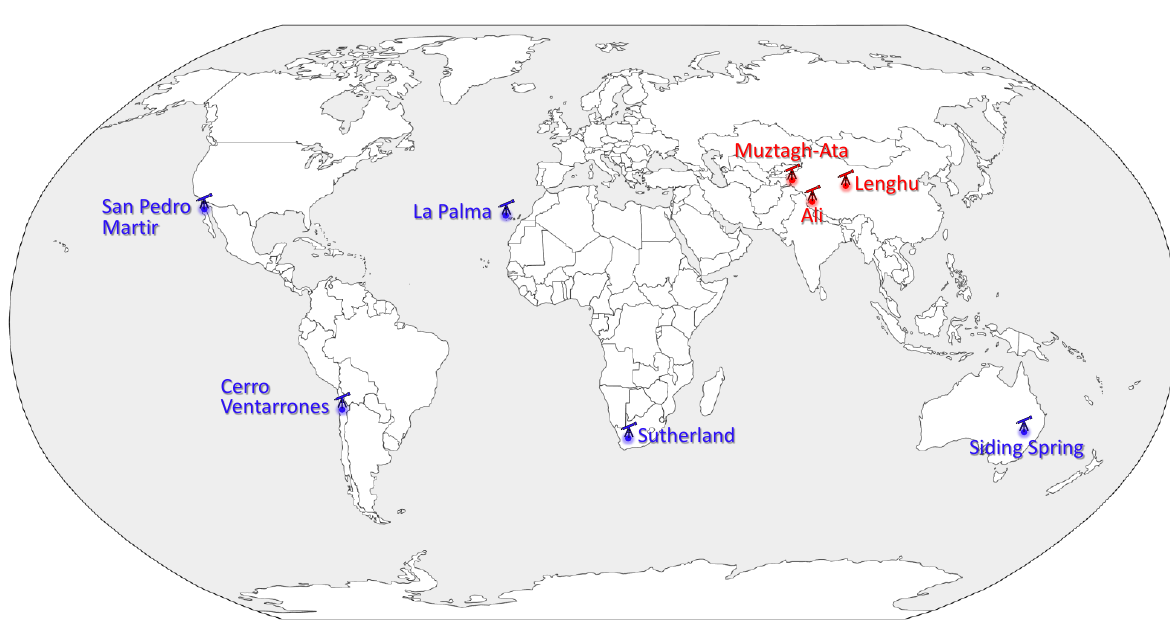
Figure 2. Location of the three Chinese sites (in red) confirmed for the first SiTian units, and of candidate sites in other countries (in blue) for the planned subsequent expansion of the